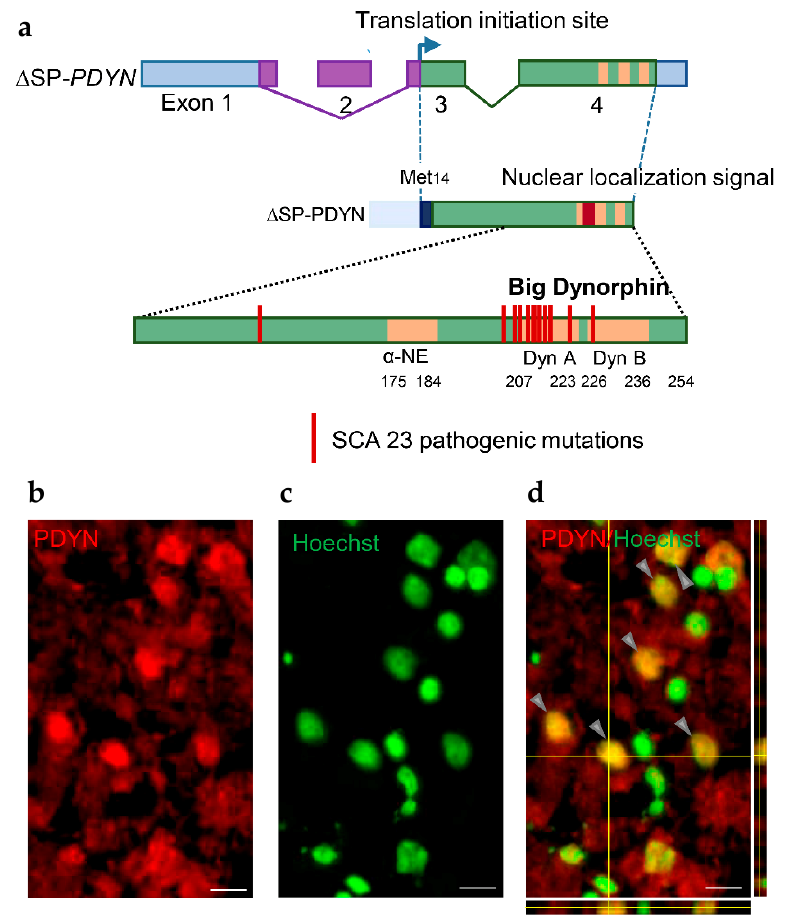
Figure 3. Structure of Δ SP- PDYN mRNA and protein, PDYN pathogenic mutations causing SCA23, and nuclear localization of ∆ SP-PDYN protein. ( a ) Δ SP -PDYN encode Δ SP-PDYN protein with truncated signal peptide. Sequences of opioid peptides α -neoendorphin ( α -NE), dynorphin A (Dyn A), dynorphinB (Dyn B), and big dynorphin (Big Dyn) are shown in yellow. Pathogenic mutations form a mutational hot spot that is localized within the pathogenic big dynorphin sequence with dynorphin A as a core. ( b,c ) PDYN immunoreactivity (red) in the nuclei (green) of neurons in the human caudate nucleus. ( d ) Double labeling (yellow) of neuronal nuclei (arrows) in 3D confocal reconstruction projections. Scale bar, 20 μ m. Modified from [46].